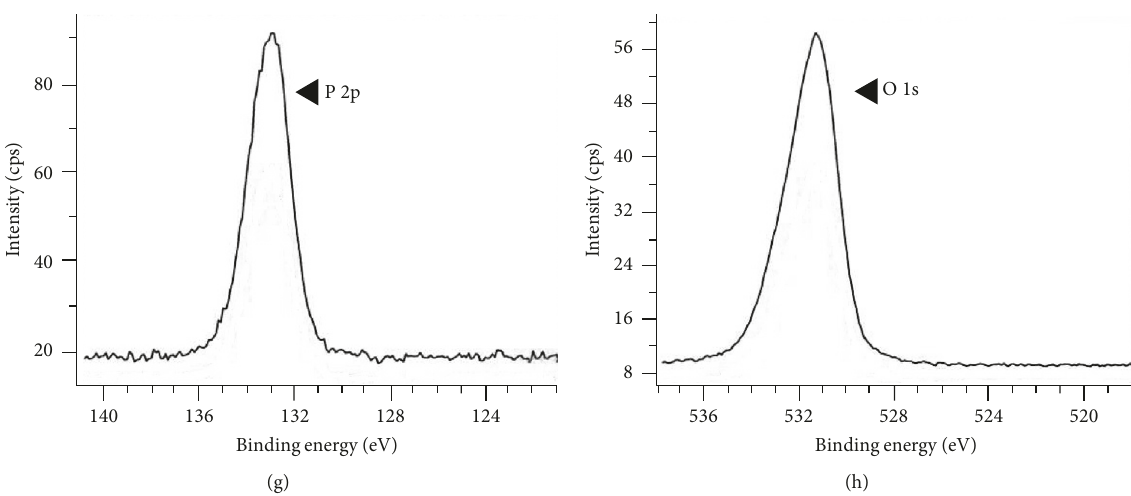
Figure 6: XPS measurements of apatite crystals. (a) XPS spectrum of apatite crystals of the Ti sensor, (b) higher resolution XPS spectrum of Ca2p of Ti sensor apatite crystals, (c) higher resolution XPS spectrum of P2p of Ti sensor apatite crystals, (d) higher resolution XPS spectrum of O1s of Ti sensor apatite crystals, (e) XPS spectrum of apatite crystals of ZrO 2 sensor, (f) higher resolution XPS spectrum of Ca2p of ZrO 2 sensor apatite crystals, (g) higher resolution XPS spectrum of P2p of ZrO 2 sensor apatite crystals, and (h) higher resolution XPS spectrum of O1s of ZrO 2 sensor apatite